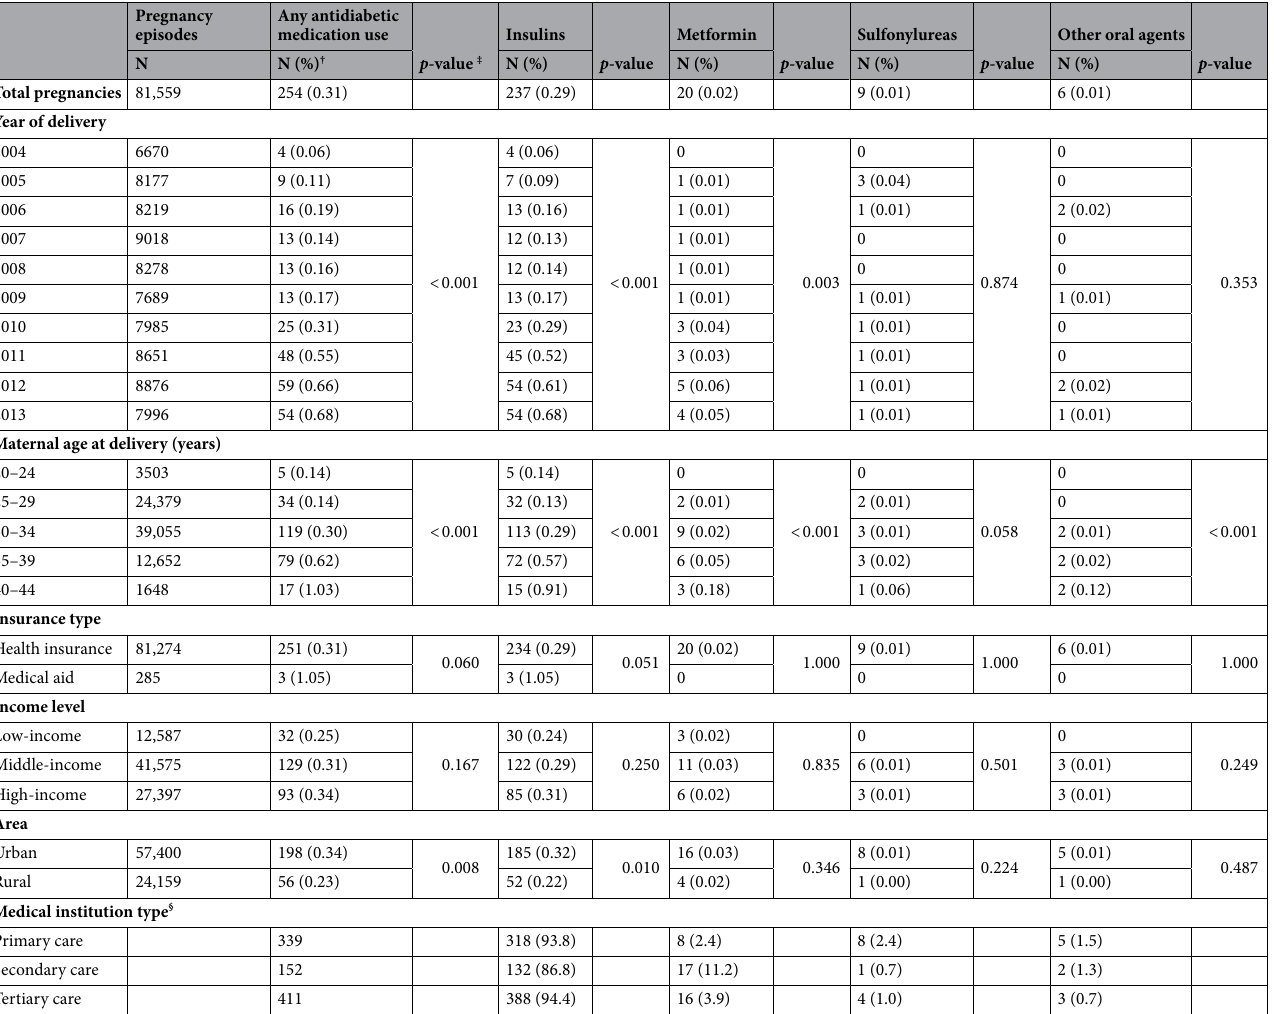
Table 4. Utilization of antidiabetic medications during the second or third trimester, by drug class *